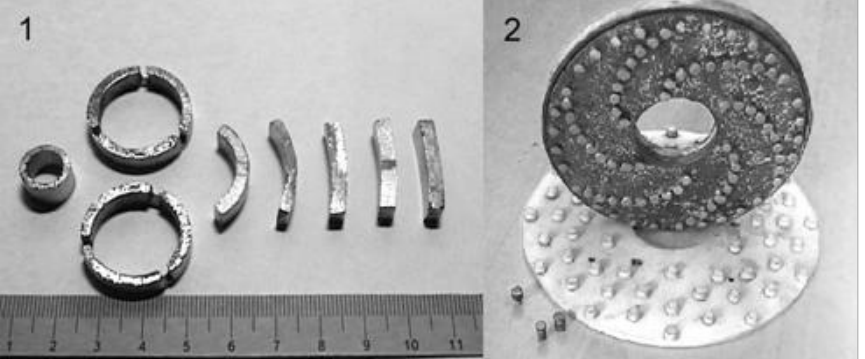
Figure 54. Examples of diamond-metal composite parts sintered by means of electric current: 1—radial segments and drill coronas; and 2—polishing head for natural stone dressing with changeable abrasive